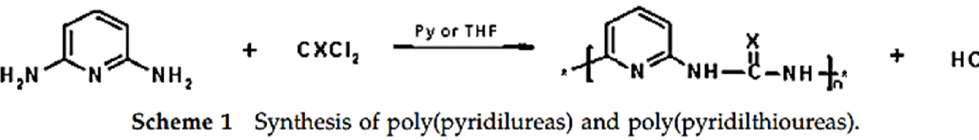
Figure 12. Synthesis of poly(pyridilureas) and poly(piridilthioureas). From reference [47]. A detailed recipe for this FET-like PU-Pyridyl and poly(pyridylthioureas) is found in reference [47].